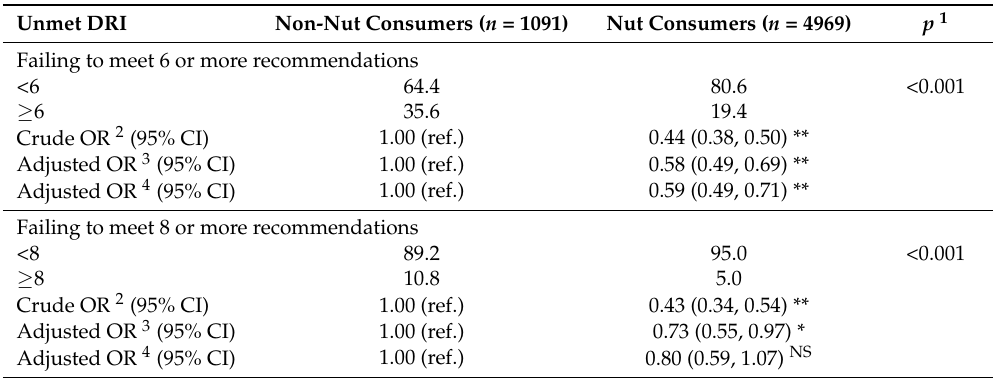
Figure 1. Mean (with standard deviation (SD)) number of nutrients with intakes not meeting the recommended levels across quintiles of nut consumption (g/day). Nut consumption range in each of the quintiles: Q1: <4.2 g/day, n = 911; Q2: 4.2–8.3 g/day, n = 1058; Q3: 8.4–14.5 g/day, n = 868; Q4: 14.6–29.3, n = 1093; Q5: ≥ 29.4 g/day, n = 1039. DRI, dietary reference intake; Q, quintile. Differences in means between quintiles were tested by one-way ANOVA ( p < 0.001) with Bonferroni’s post-hoc test. Different letters indicate statistically significant differences between quintile groups. Table 4. Unmet dietary reference intakes (DRI) ≥ 6 and ≥ 8 number of nutrients in nut-consumers ( n = 4969) compared with non-nut consumers as reference value ( n = 1091).